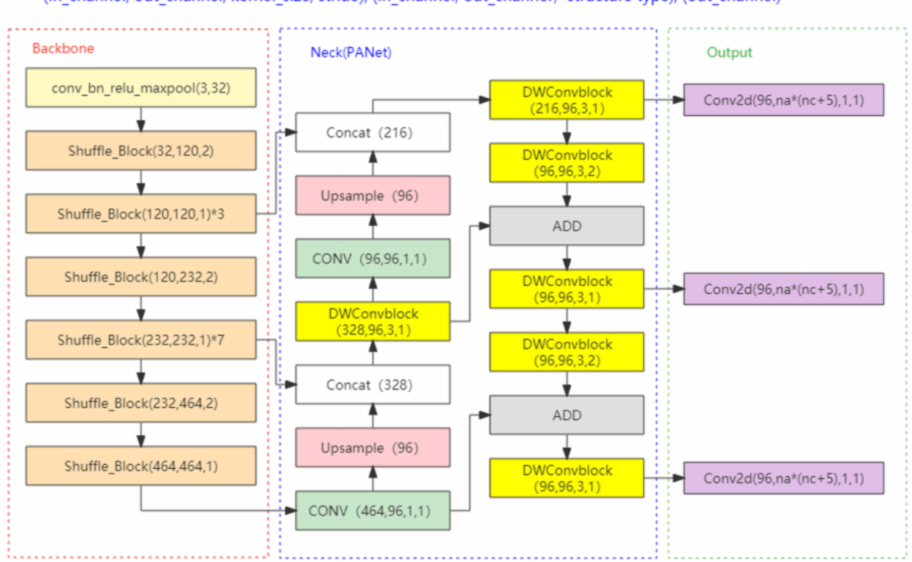
Figure 6. Detection network structure of improved YOLOv5.